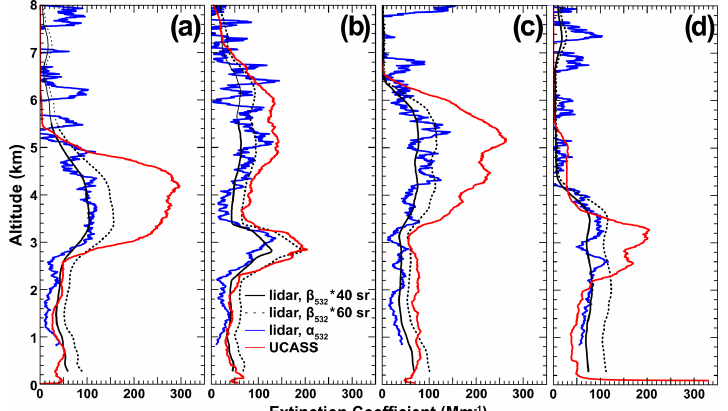
Figure 9. Aerosol extinction coefficient profiles from UCASS (red) and the Raman lidar Polly XT at Limassol. Lidar profiles refer to extinction coefficients obtained using the Raman method (blue) or by multiplying the aerosol backscatter coefficient derived without the use of Raman signals with lidar ratios of 40sr (solid black line) and 60sr (dotted black line). Panels refer to the first (a) , second (b) , third (c) , and fourth (d) UCASS launches (see Fig. 1 and Table